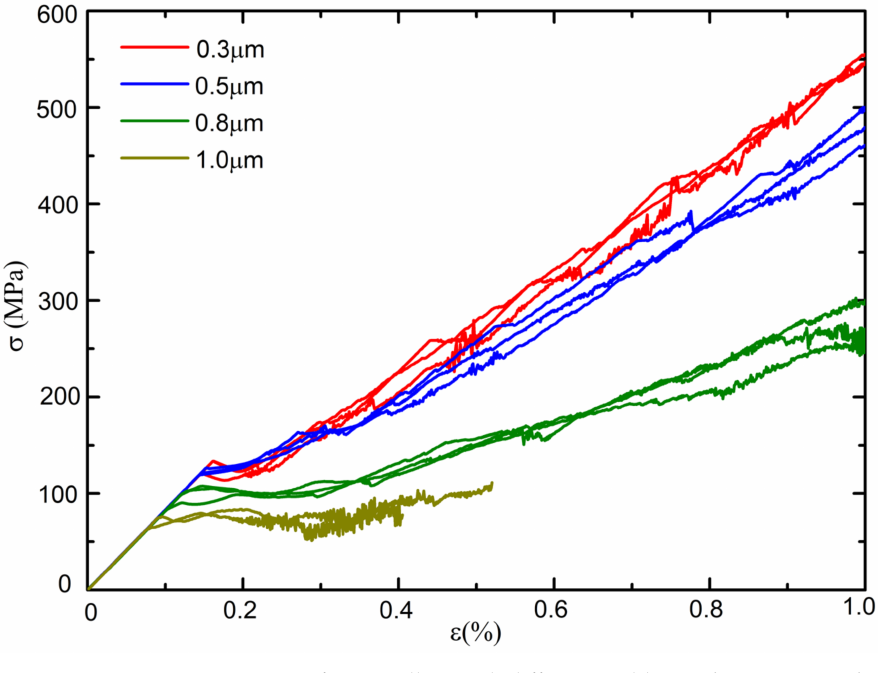
Figure 10. Stress–strain curves of micropillars with different widths L = {0.3, 0.5, 0.8,1.0} µ m.